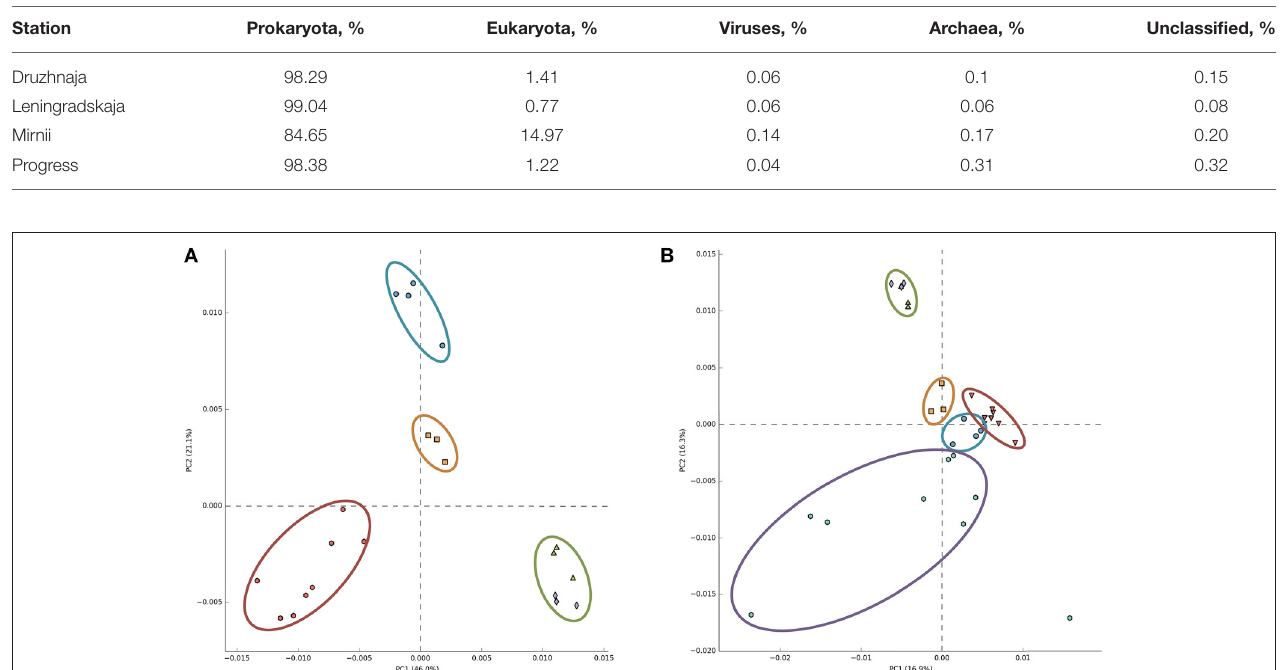
FIGURE 4 | Principal component analysis of 30 metagenomes from five different environments based on frequencies of COG categories. A scatter plot of PCA-scores depicting variance of COG categories detected in different environmental metagenomes. In panel (A) COGs from Antarctic snow (cyan) are compared to temperate soil samples (red), sea water (green), and Antarctic microbial mat (orange). In panel (B) Arctic snow samples (violet) are included in